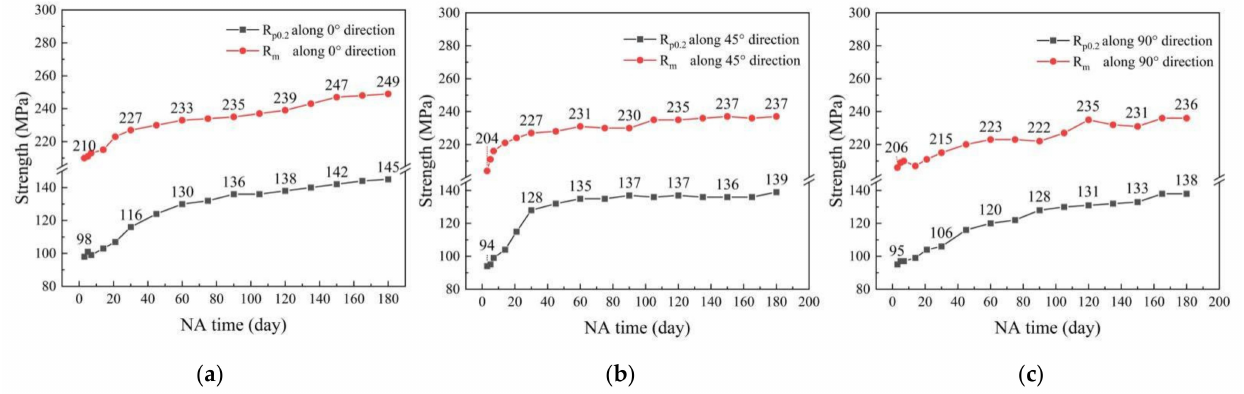
Figure 6. The change curves of R p0.2 and R m along 0 ◦ ( a ), 45 ◦ ( b ), and 90 ◦ ( c ) directions during six months of NA.